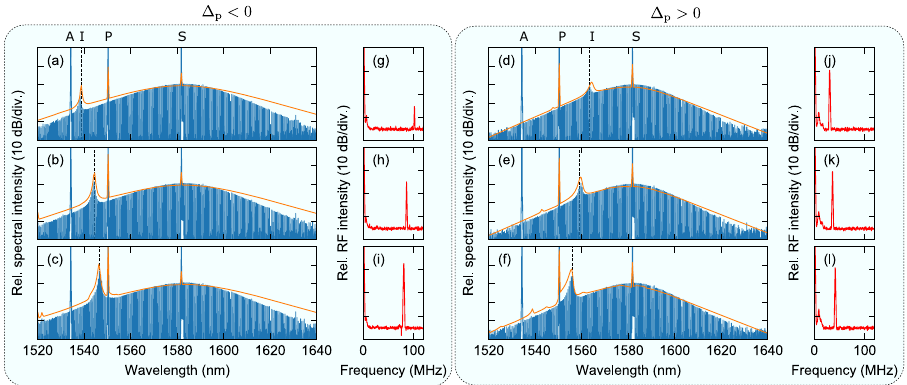
Fig. 3 Experimental spectra with the soliton-generating pump at 1582nm and the probe at 1550nm. a – c Blue curves show microcomb spectra measured at the resonator output for different negative values of the probe detuning, such that the idler is generated at wavelengths shorter than the probe. Orange curves show corresponding results from simulations and the dashed vertical lines show the phasematched wavelength predicted by Eq. (5). d – f show spectra as in ( a – c ) but for different positive values of the probe detuning, such that the idler is generated at wavelengths longer than the probe. g – l Radio- frequency (RF) spectra corresponding to ( a – f ). The beat frequencies in the RF spectra correspond to the offset between the soliton and the idler combs, d ω /(2 π ). Labels A, I, P, and S on the top respectively indicate the auxiliary laser used for thermal compensation, the idler, the probe, and the soliton.